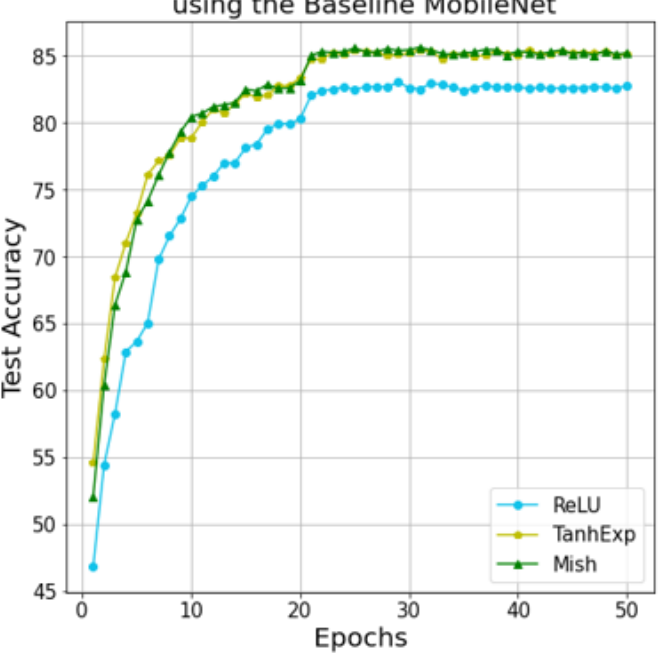
Figure 7. Comparison between accuracy of Mish, TanhExp and ReLU activation functions using the baseline MobileNet on